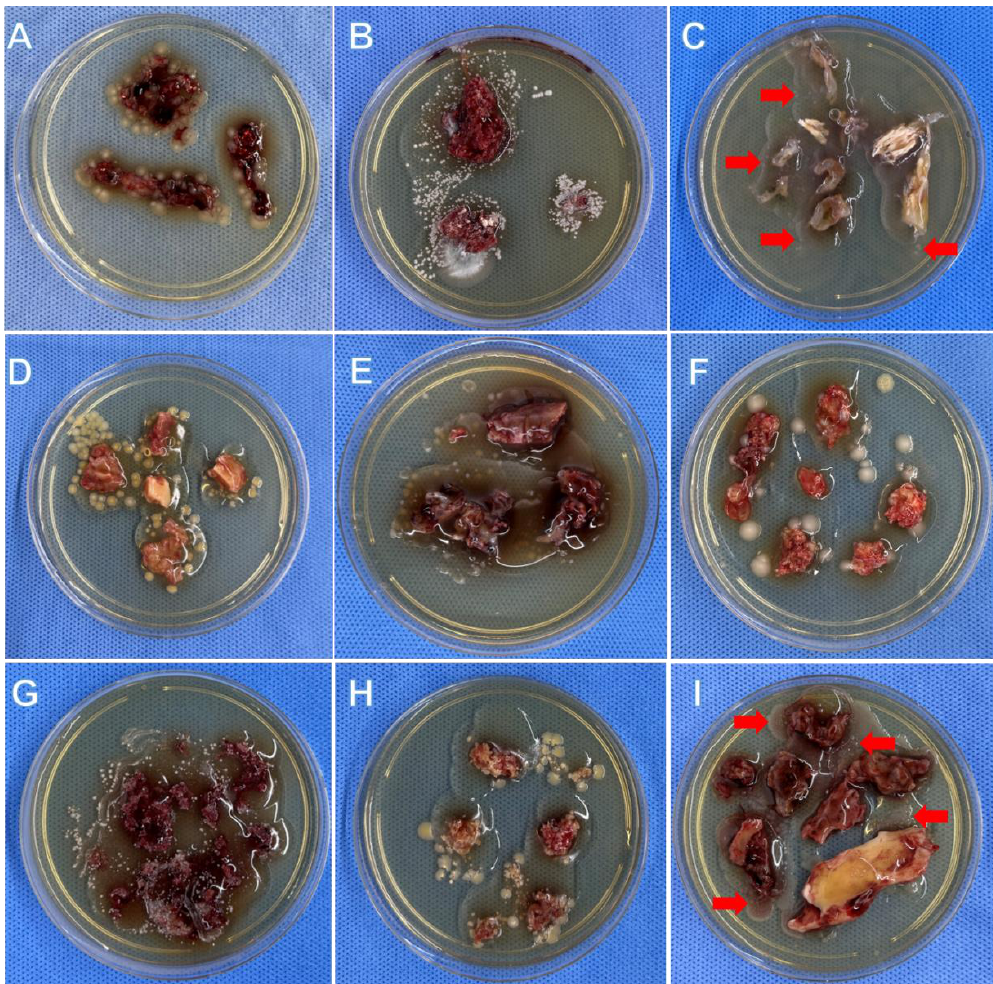
Figure 4. Nine OM patients showed positive outcomes using the BSC method. Panel ( A ): 49-year-old, male, tibia OM, BSC: Escherichia coli , TSC: Escherichia coli. Panel ( B ): 32-year-old, female, BSC: Candida parapsilosis , TSC: Candida parapsilosis . Panel ( C ): 71-year-old, male, tibia OM, BSC: Proteus mirabilis , TSC: Proteus mirabilis (see the arrows). Panel ( D ): 50-year-old, male, tibial OM, BSC: Staphylococcus aureus , TSC: Staphylococcus aureus . Panel ( E ): 16-year-old, male, femoral OM, BSC: Enterococcus faecalis , TSC: Negative. Panel ( F ): 42-year-old, male, tibia OM, BSC: Enterobacter cloacae , TSC: Negative. Panel ( G ): 39-year-old, male, tibia OM, BSC: Mycobacterium fortuitum , TSC: Mycobacterium fortuitum . Panel (H ): 47-year-old, male, calcaneal OM, BSC: Staphylococcus aureus , TSC: Staphylococcus aureus . Panel ( I ): 43-year-old, male, femoral OM, BSC: Enterobacter aerogenes , TSC: Enterobacter aerogenes (see the arrows).